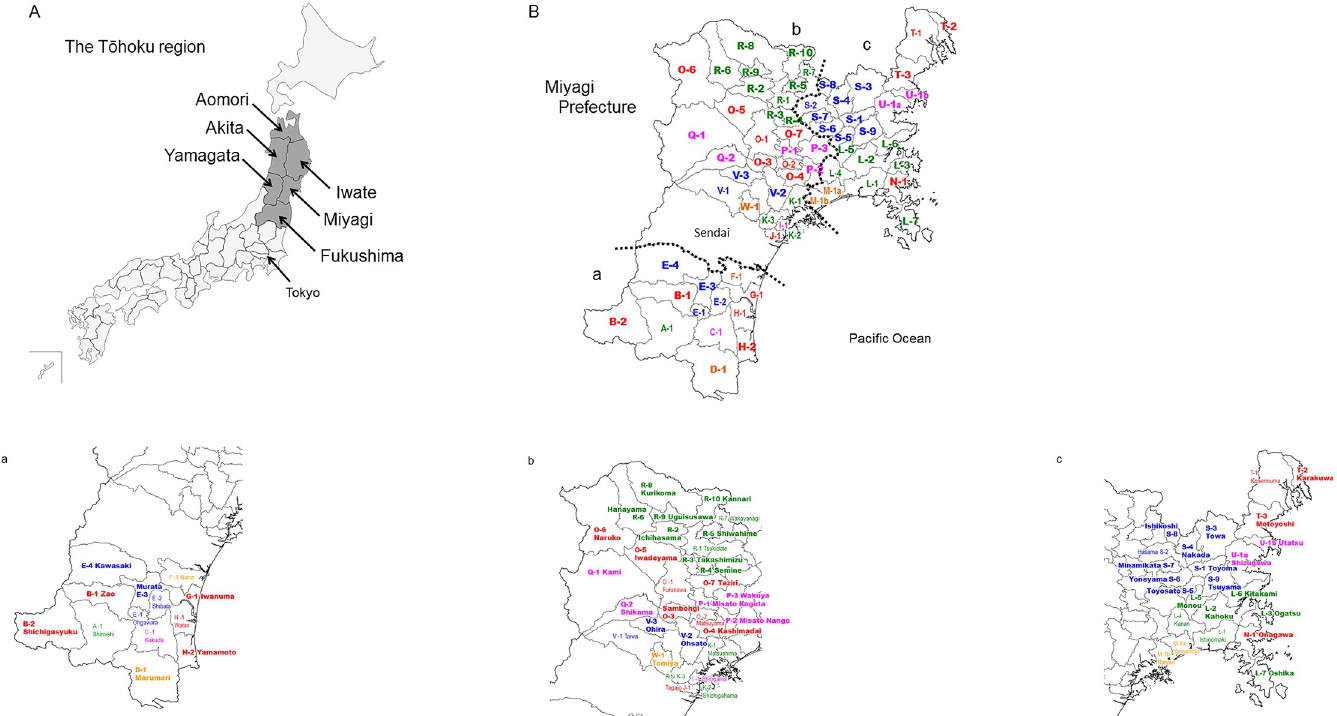
Fig 1. The Tohoku region in Japan and the survey area in the Miyagi Prefecture. (A) The Tohoku Region has six prefectures: Aomori Prefecture, Iwate Prefecture, Miyagi Prefecture, Akita Prefecture, Yamagata Prefecture, and Fukushima Prefecture. (B) The survey area in Miyagi. Enlarged views are presented for each of the areas a, b, and c. Also, see S1 Table for details. Bold style code numbers represent areas where cervical cancer screenings were performed by mobile